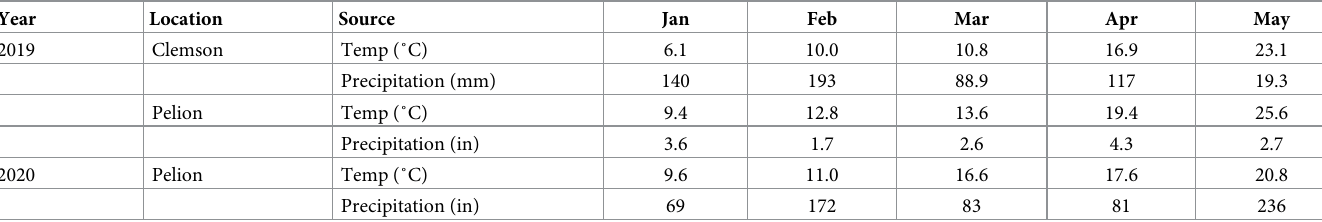
Table 2. Mean monthly temperature and precipitation for two growing locations in SC, USA.